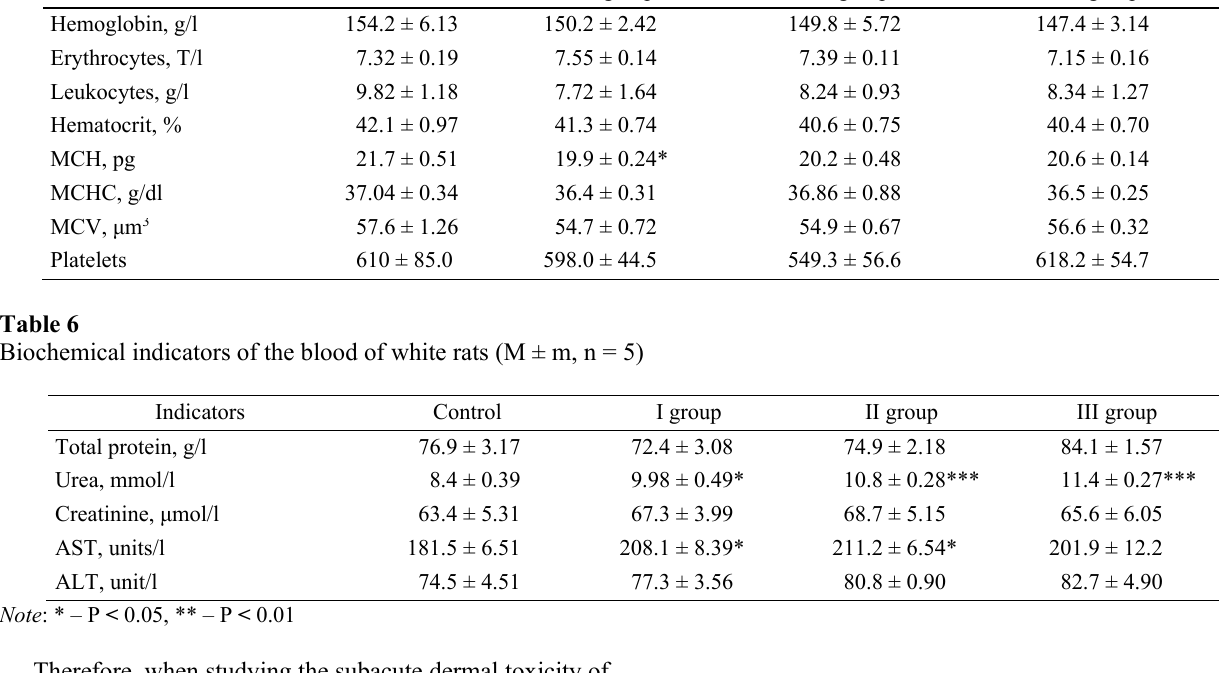
Hematological indicators of the blood of white rats (M ± m, n = 5) Indicators